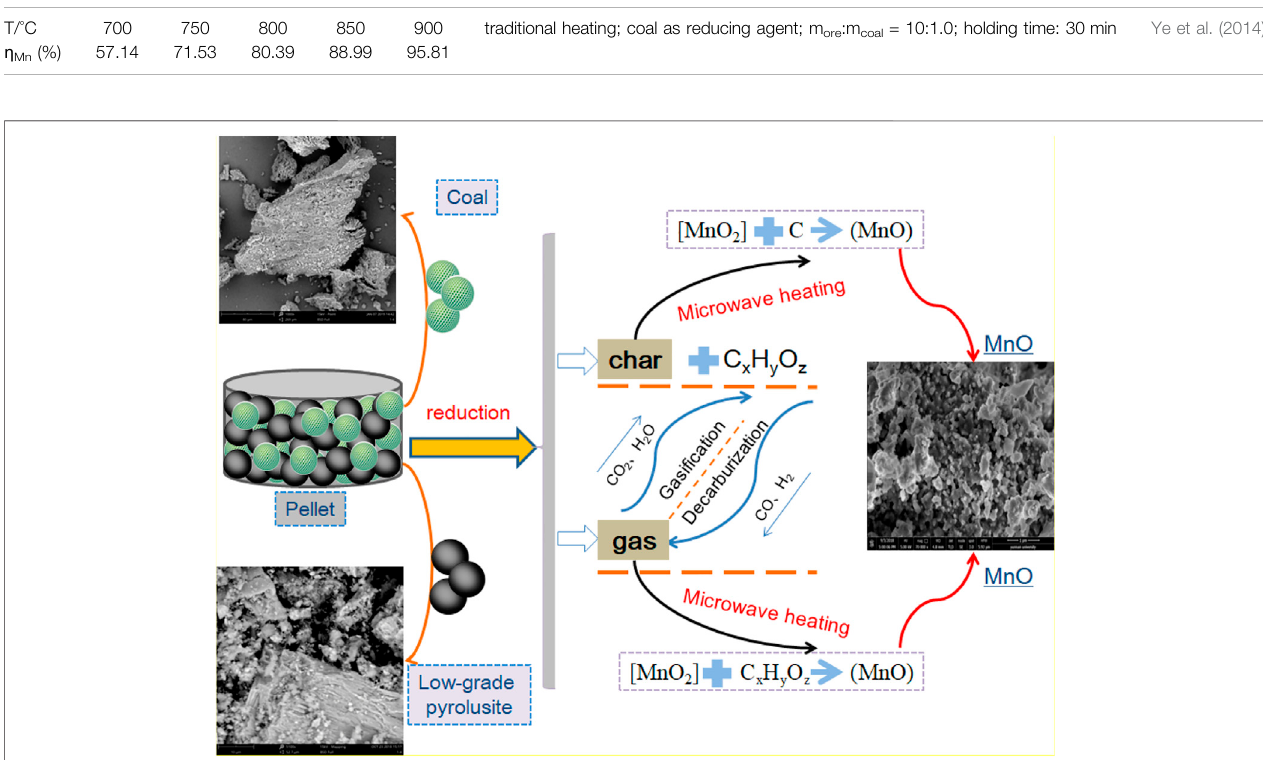
FIGURE 6 | Mechanism diagram of microwave carbothermal reduction of low-grade pyrolusite.